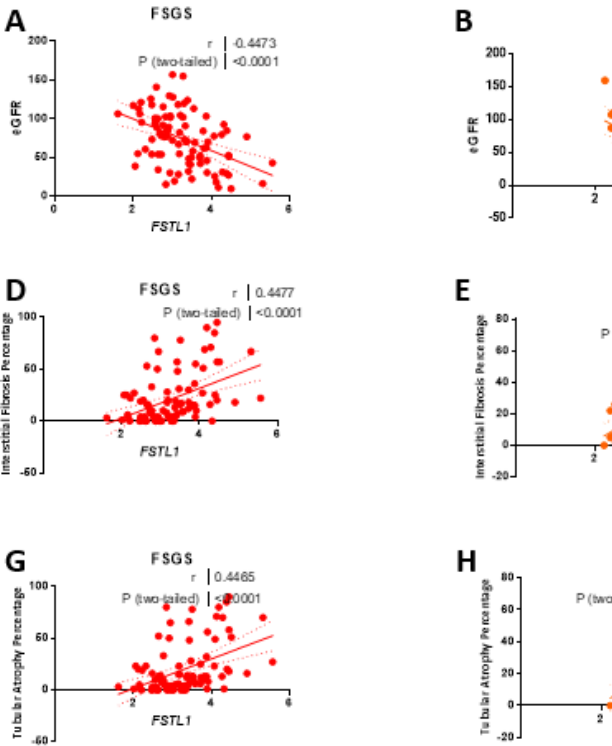
Figure 23. Clinical FSTL1 expression in FSGS (red), IgAN (orange), and MN (purple). ( A ) eGFR correlated to FSTL1 mRNA levels in FSGS patients. ( B ) eGFR correlated to FSTL1 mRNA levels in IgAN patients. ( C ) eGFR correlated to FSTL1 mRNA levels in MN patients. ( D ) Interstitial fibrosis (IF) correlated to FSTL1 mRNA levels in FSGS patients. ( E ) Interstitial fibrosis (IF) correlated to FSTL1 mRNA levels in IgAN patients. ( F ) Interstitial fibrosis (IF) correlated to FSTL1 mRNA levels in MN patients. ( G ) Tubular atrophy (TA) correlated to FSTL1 mRNA levels in FSGS patients. ( H ) Tubular atrophy (TA) correlated to FSTL1 mRNA levels in IgAN patients. ( I ) Tubular atrophy (TA) correlated to FSTL1 mRNA levels in MN patients. Pearson’s correlation coefficient ( r ) was determined, and two-tailed p values derived. Significance was determined as a p value of <0.05. Linear regression generated the line of best fit (solid lines) with 95% confidence intervals (dotted lines).